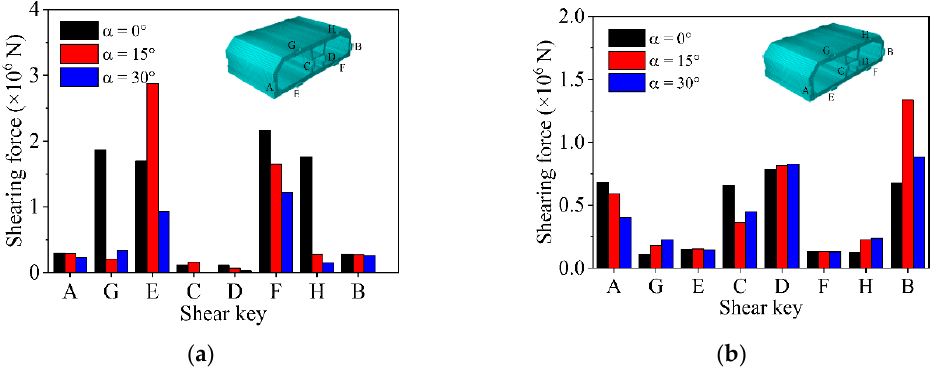
Figure 21. Shearing force of segment at different angles of incidence: ( a ) transverse; ( b ) vertical.